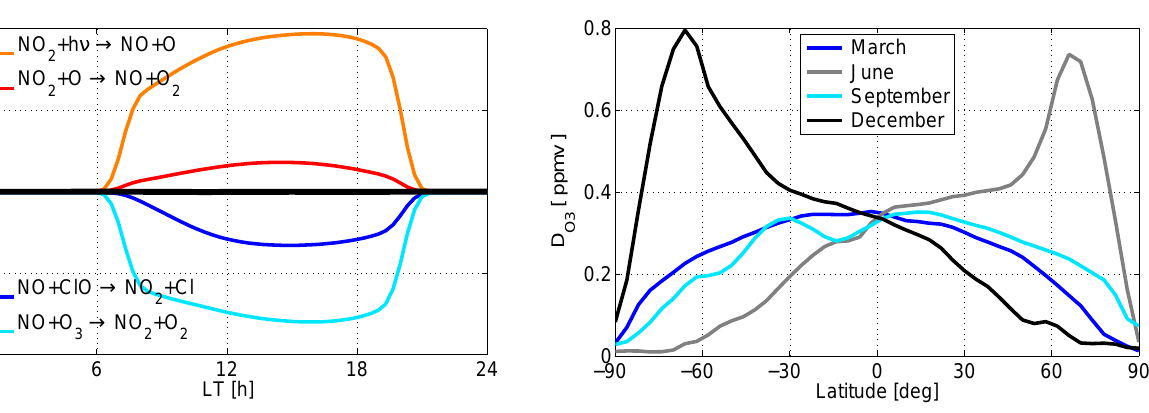
Figure 3. Zonal-mean conversion rates of NO at 5hPa, 21 March, 50 ◦ N. The corresponding reactions are given next to the conversion lines. The net conversion rate of NO (black line) show negligible conversion rate since common NO changes at the solar terminator are from 0 to approximately 10ppbv. Reactions with absolute con- version rates less than 5ppbvh − 1 are omitted.